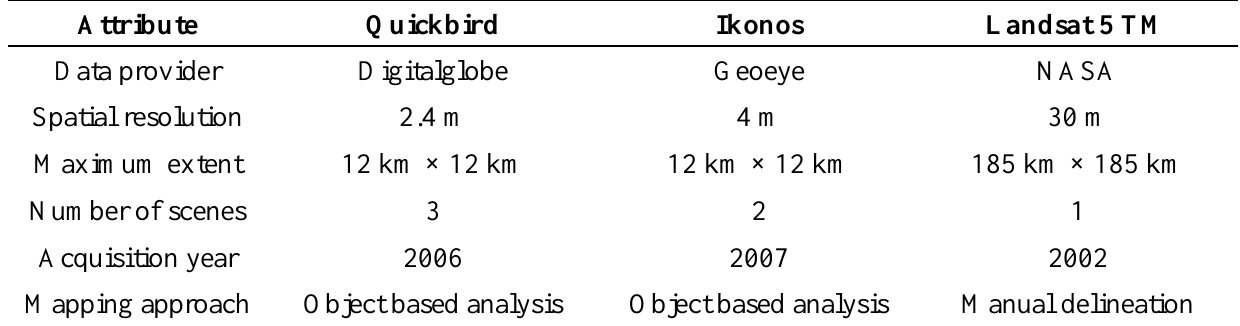
Table 2. Attributes of satellite data sets